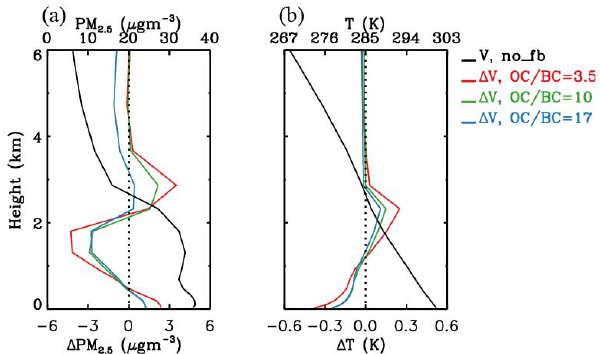
Fig. 10. Vertical distribution of monthly/domain averaged variables over the smoke source region in October 2006 for different OC/BC ratios: (a) PM 2 . 5 concentration, (b) air temperature. The black line is the variable ( V ), and the 3 other lines are the differences of the variable due to smoke ( 1V = V Ra − V non-Ra ) with different OC/BC ratio. (In the case of OC/BC are 3.5, 10 and 17, respec-